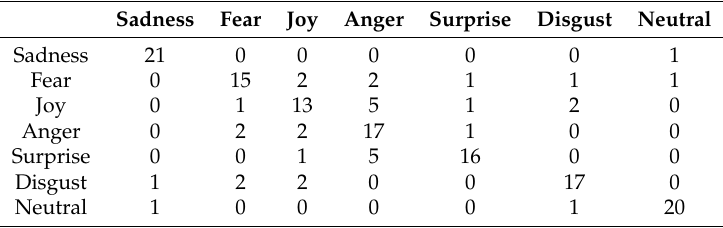
Table A5. P5 actor confusion matrix from the RekEmozio dataset in the second phase.